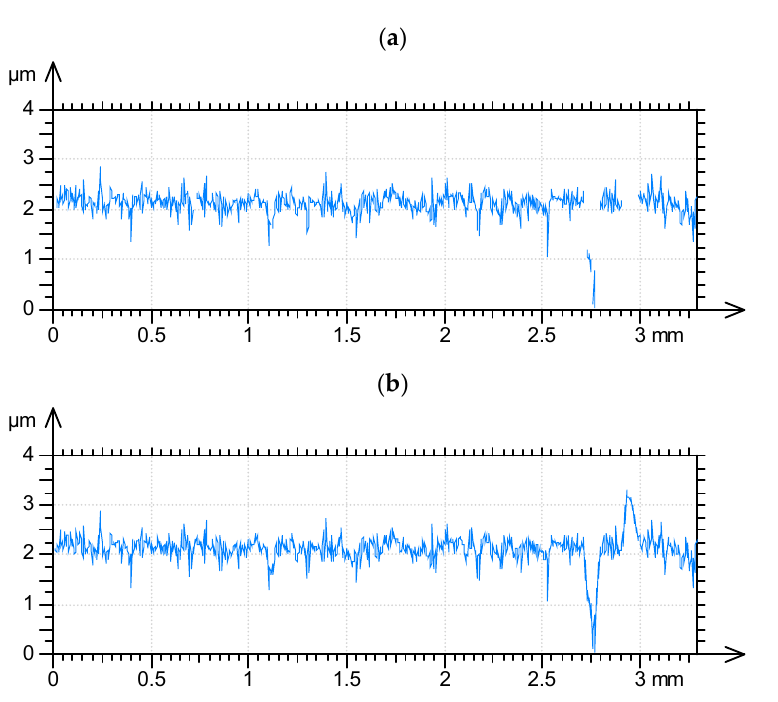
Figure 4. Plateau honed profile measured by white light interferometer ( a ) and with filled in non- measured points ( b ).